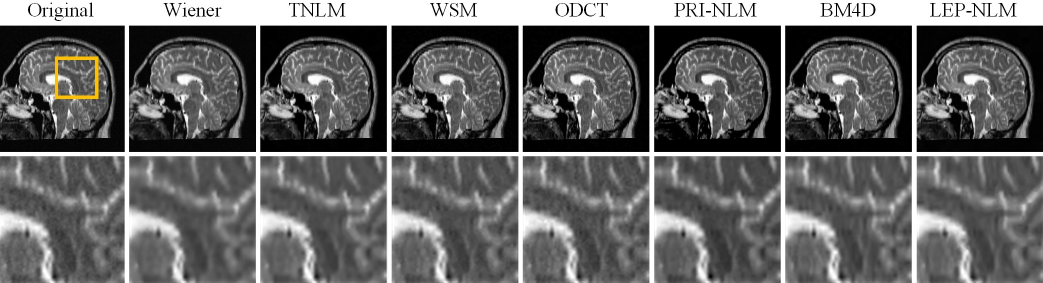
Figure 6. The restoration results of a real T2-weighted brain MR image by the various denoising filters. From top to bottom: the original MR images and the corresponding enlarged portions of ROIs marked with the yellow box in the original images.